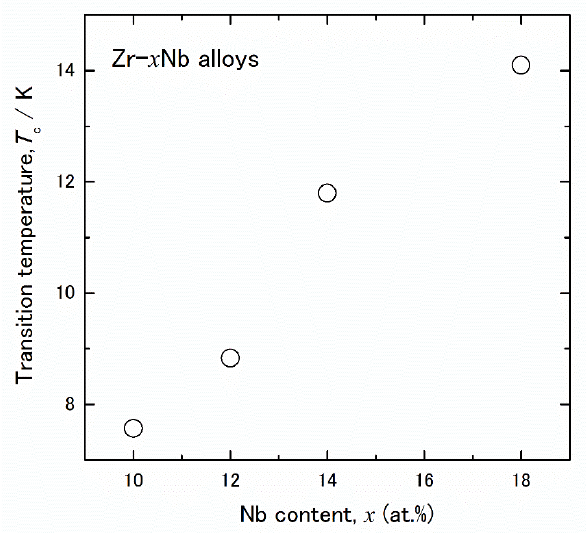
Figure 2. Nb content dependence of the superconductive transition temperature ( T c ) of Zr-x at.% Nb (10 ≤ x ≤ 18) alloys.